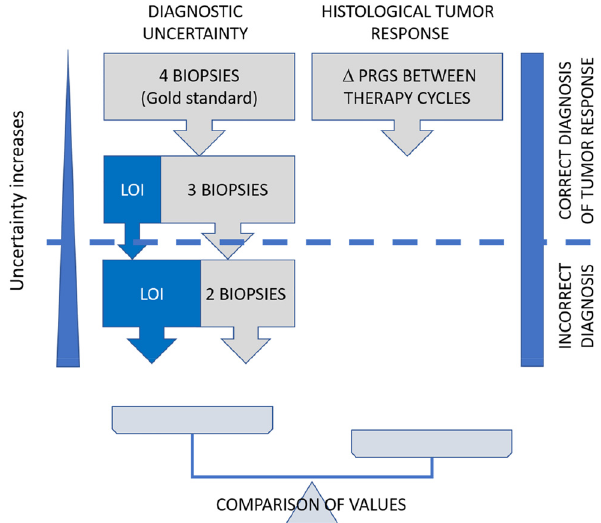
Figure 1: Study flow. We determined the mean PRGS from all four peritoneal biopsies, and the loss of information (LOI) associated with one and two biopsies missing (left part). In parallel, the mean difference in PRGS between consecutive chemotherapy cycles was documented (right part). When the loss of information outweighed the 95% CI of the observed difference, the diagnosis of regression vs. progression was considered false. Δ PRGS = difference in mean PRGS between consecutive therapy cycles.